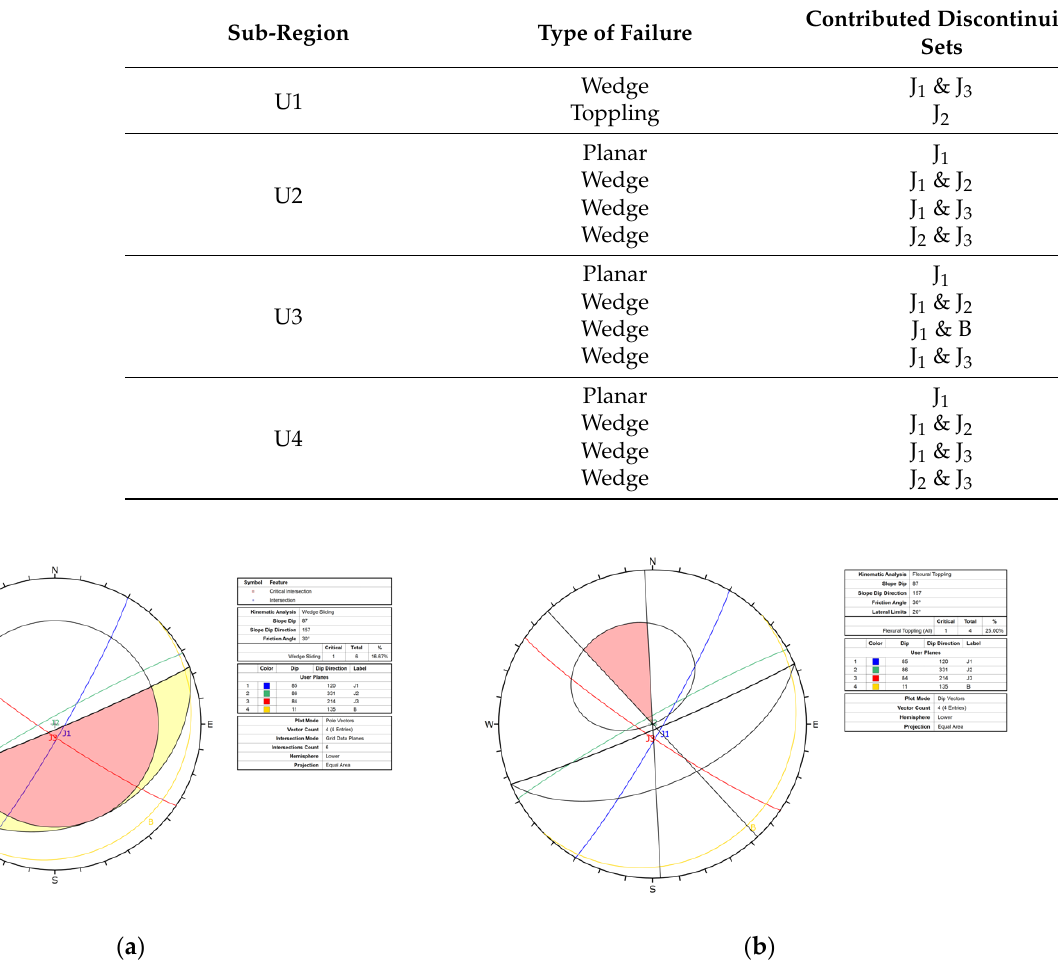
Table 3. A concise review of the kinematic analysis per sub-region.